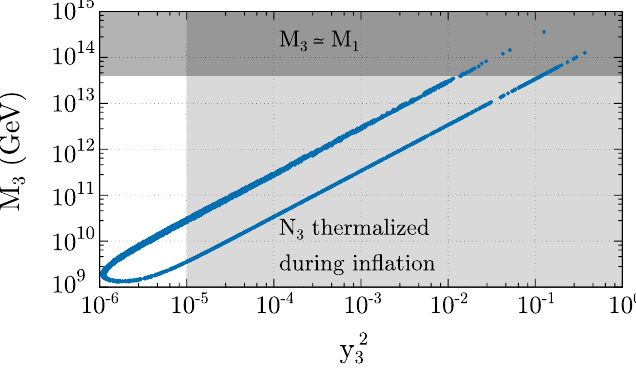
Figure 6 . Mass of the lightest right-handed neutrino, N 3 , as a function of its effective Yukawa coupling, | y 3 | . All neutrino observables are required to be within the 3 σ experimental range and we have fixed y = 0 . 74 , M 1 = 4 . 6 × 10 14 GeV, and Y B = 7 . 5 × 10 − 11 . The light-gray shaded region shows the forbidden region if the N 3 neutrino thermalizes during inflation, and the gray shaded region estimates the breakdown of the approximation M 3 (cid:28) M 1